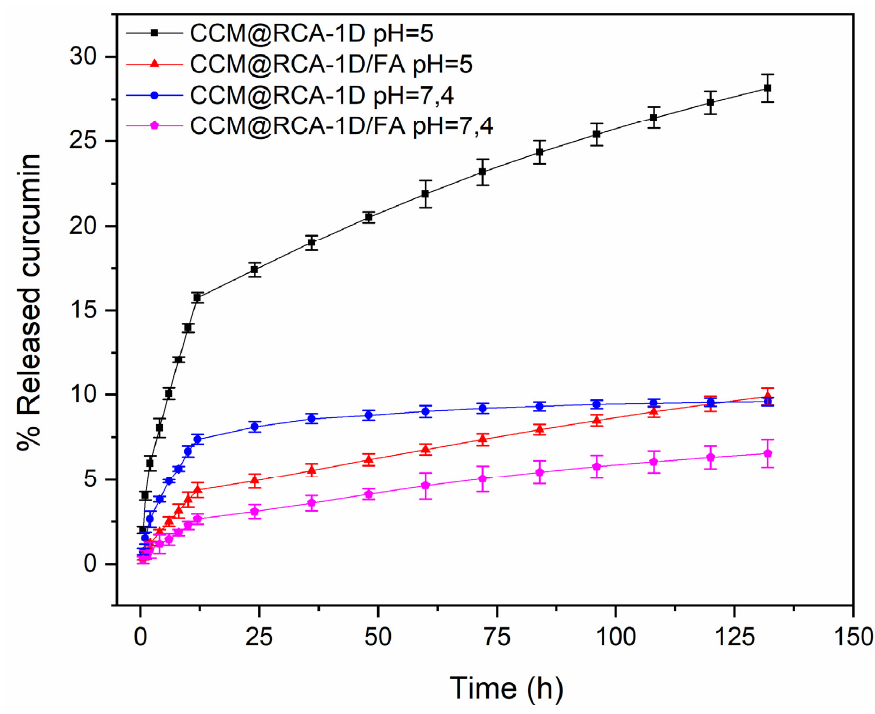
Figure 13. CCM release profiles in samples.